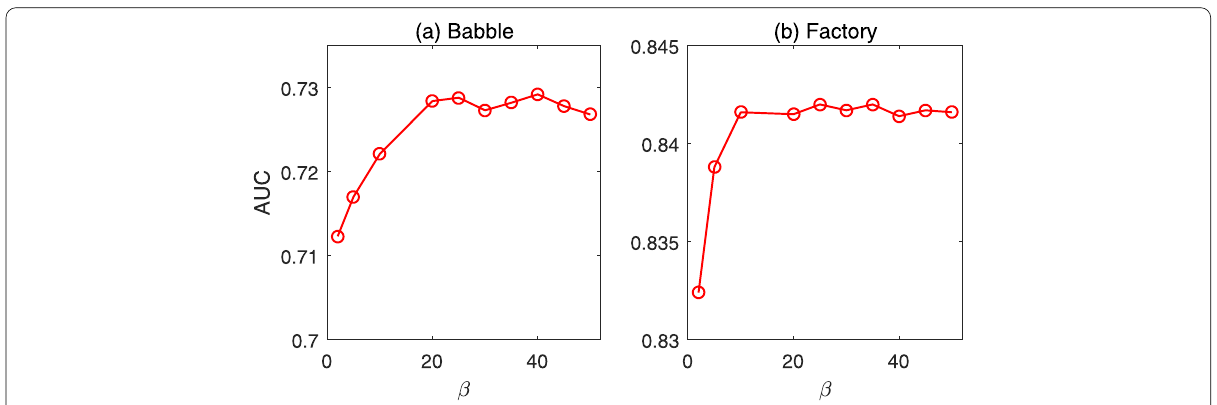
Fig. 5 Effect of the hyperparameter β of MaxAUC sigm VAD on the Chinese development dataset at − 5 dB